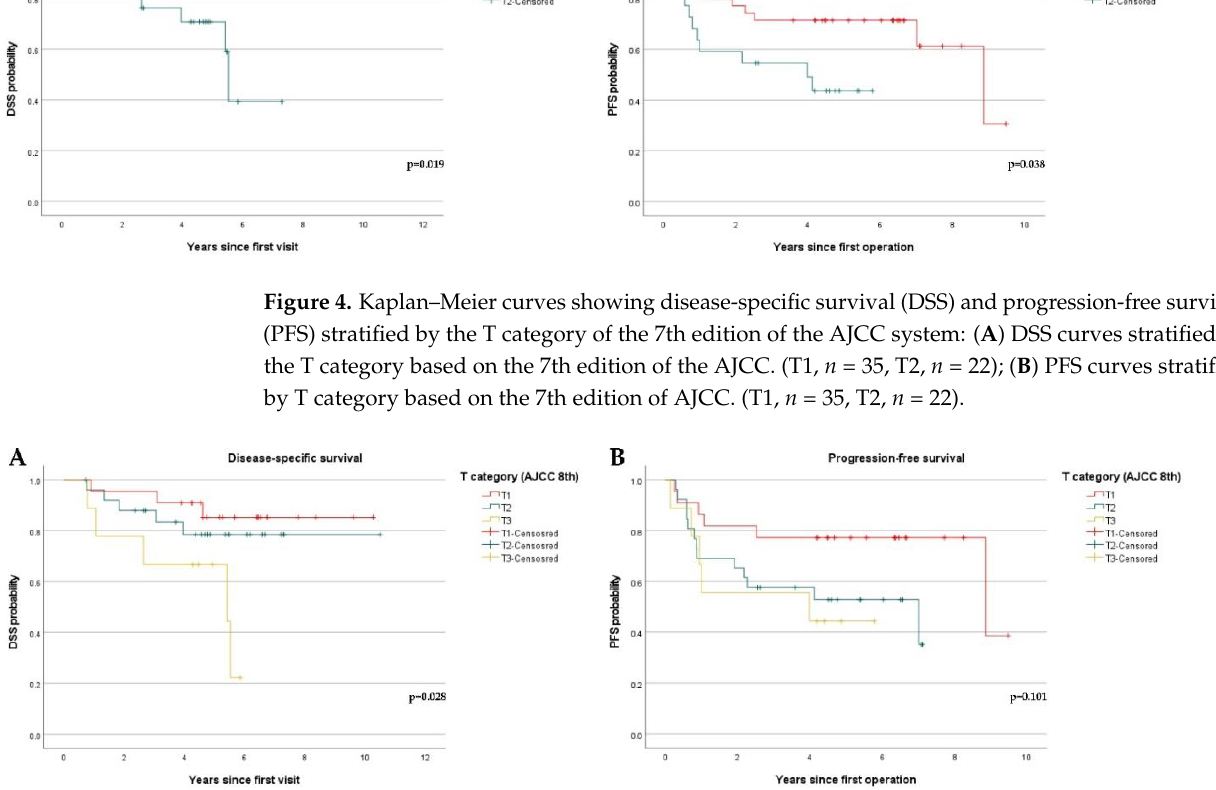
Figure 5. Kaplan–Meier curves showing disease-specific survival (DSS) and progression-free survival